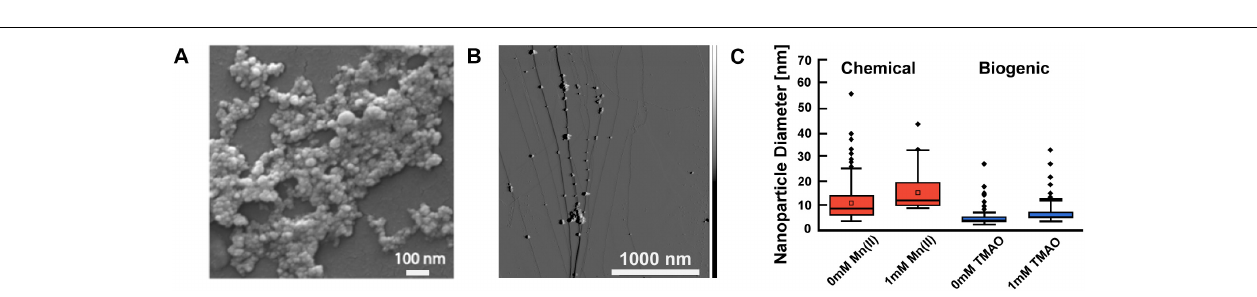
FIGURE 3 | XRD spectrum of Mn doped ZnS nanomaterials synthesized via (A) the chemical route and (B) the biogenic route using engineered Shewanella oneidensis JG3631. XRD spectrum confirms the material synthesized is crystalline and has zincblende crystalline orientation, shown as reference.